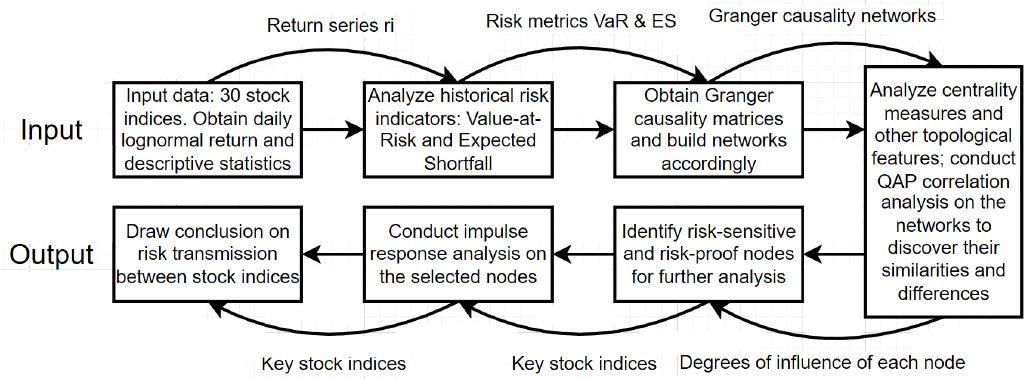
Figure 1. Flow Chart of Our Research Methodology.